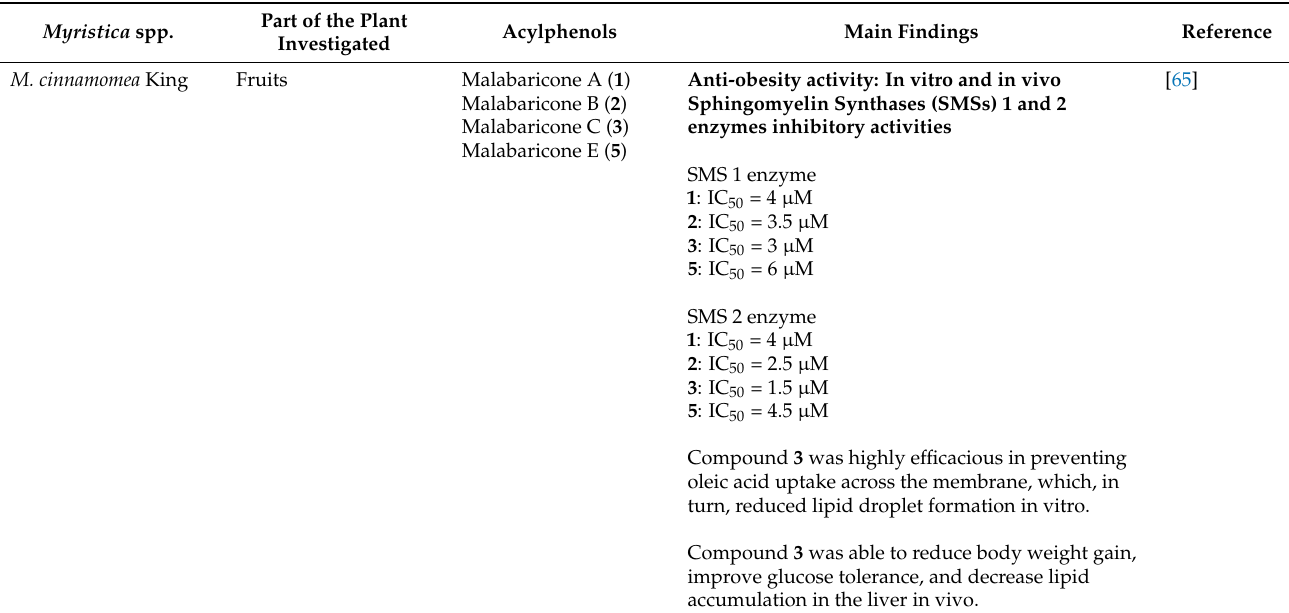
Table 12. The anti-obesity activity of acylphenols from the genus Myristica .